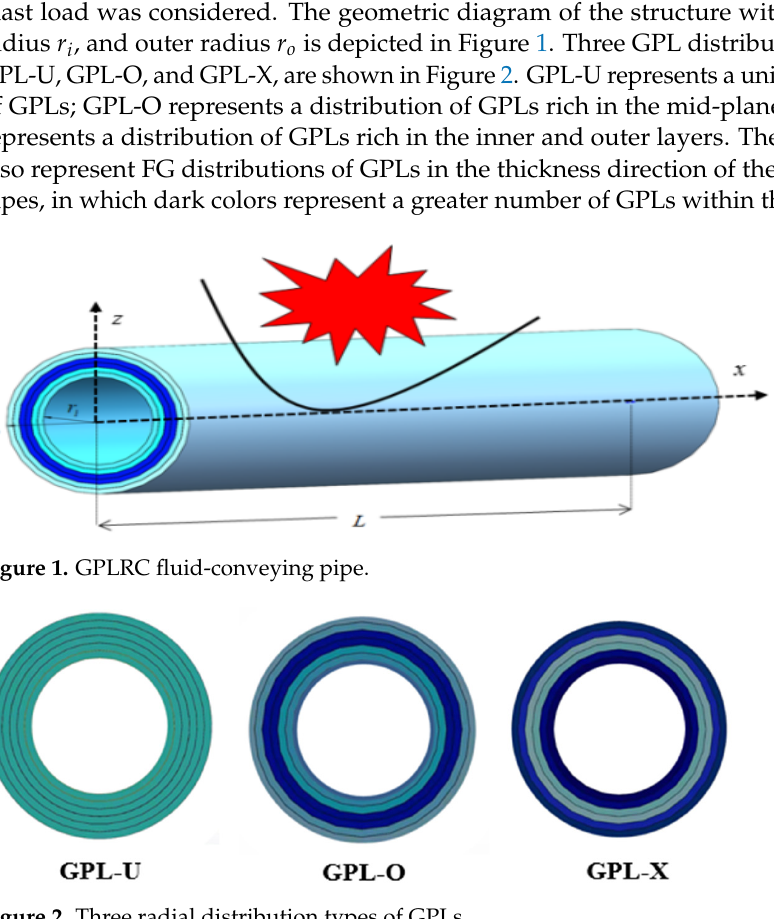
Figure 2. Three radial distribution types of GPLs.